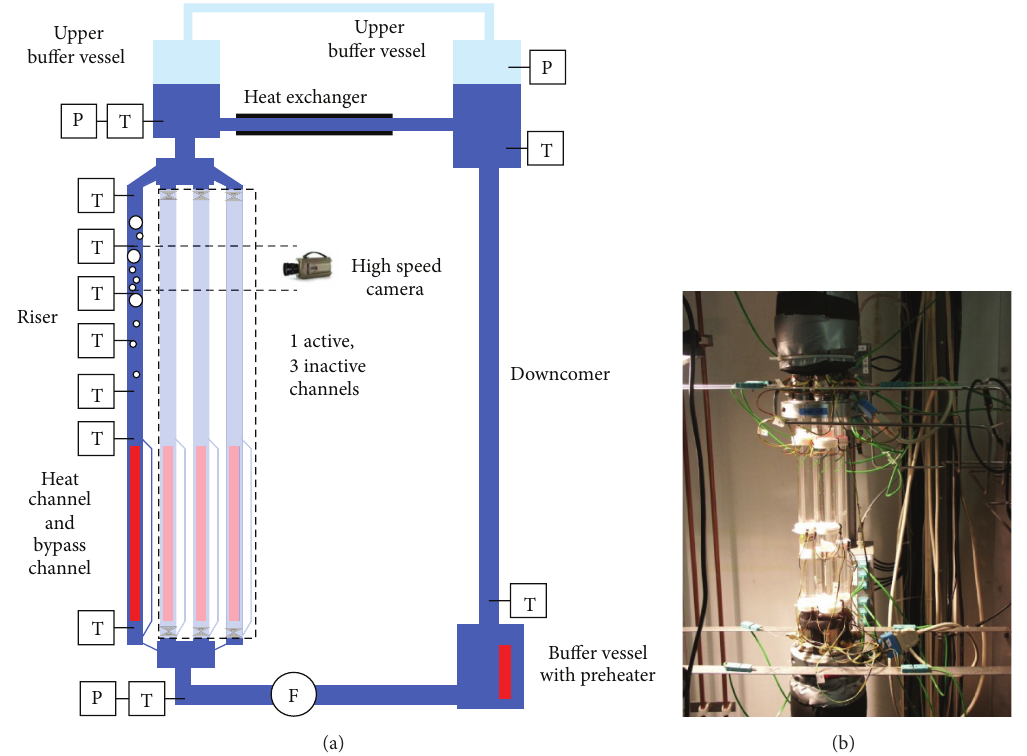
Figure 1: CIRCUS-IV test facility (a) and uncovered riser section for flow observation